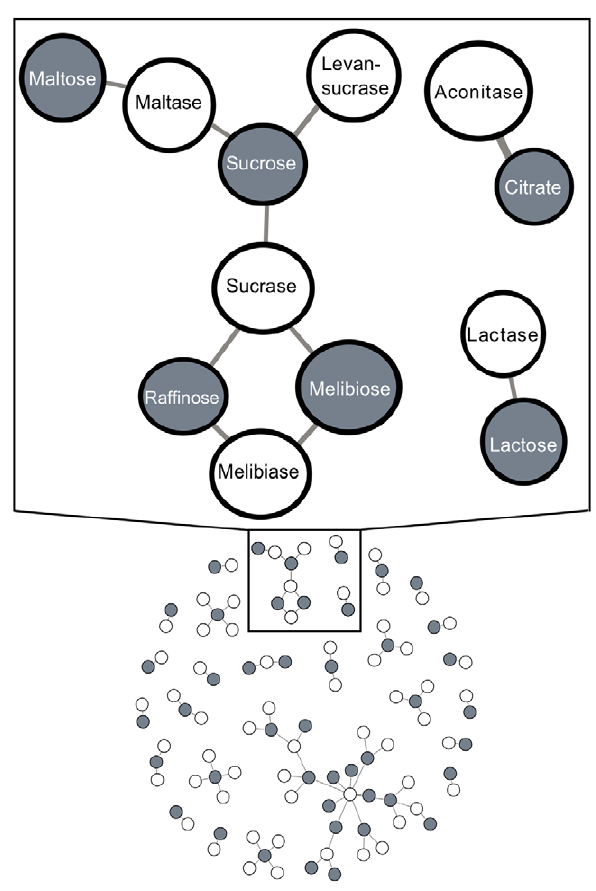
Figure 5. Most enzymes are specialized for catabolism of one or a few carbon sources. White nodes indicate enzymes and gray nodes indicate carbon sources. Edges represent the enzymes that process each carbon